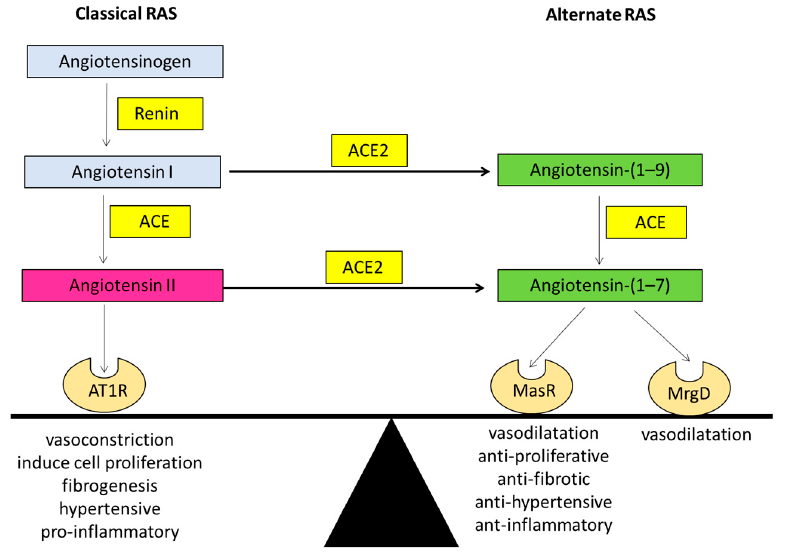
Figure 1. The ‘balance’ between the two arms of the renin angiotensin system (RAS). Graphical representation of the classical arm (ACE/Angiotensin II/AT1R) and the alternate arm (ACE2/Angiotensin-(1–7)/MasR) of the RAS where the alternate arm counter-balances the deleterious effects of the classical arm. Angiotensin II can exert its effects via the angiotensin II type 1 receptor (AT1R). Whilst angiotensin-(1–7) of the alternate RAS acts mainly via the Mas receptor (MasR), recent evidence suggests that it also transduces its signal via the Mas related G protein-coupled receptor type-D (MrgD). ACE: angiotensin converting enzyme; ACE2: angiotensin converting enzyme 2.